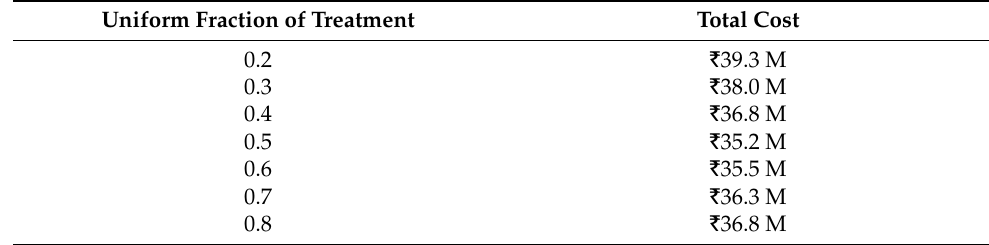
Table 8. Cost of graywater reuse implementation for a constant fraction of treatment: IIT Madras network.